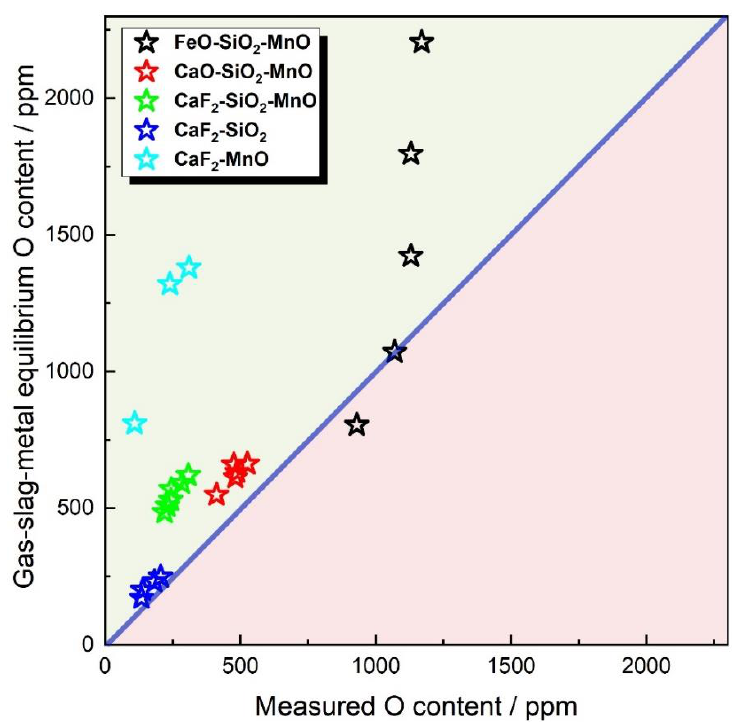
Figure 11. WM oxygen content as a function of oxide content in flux.